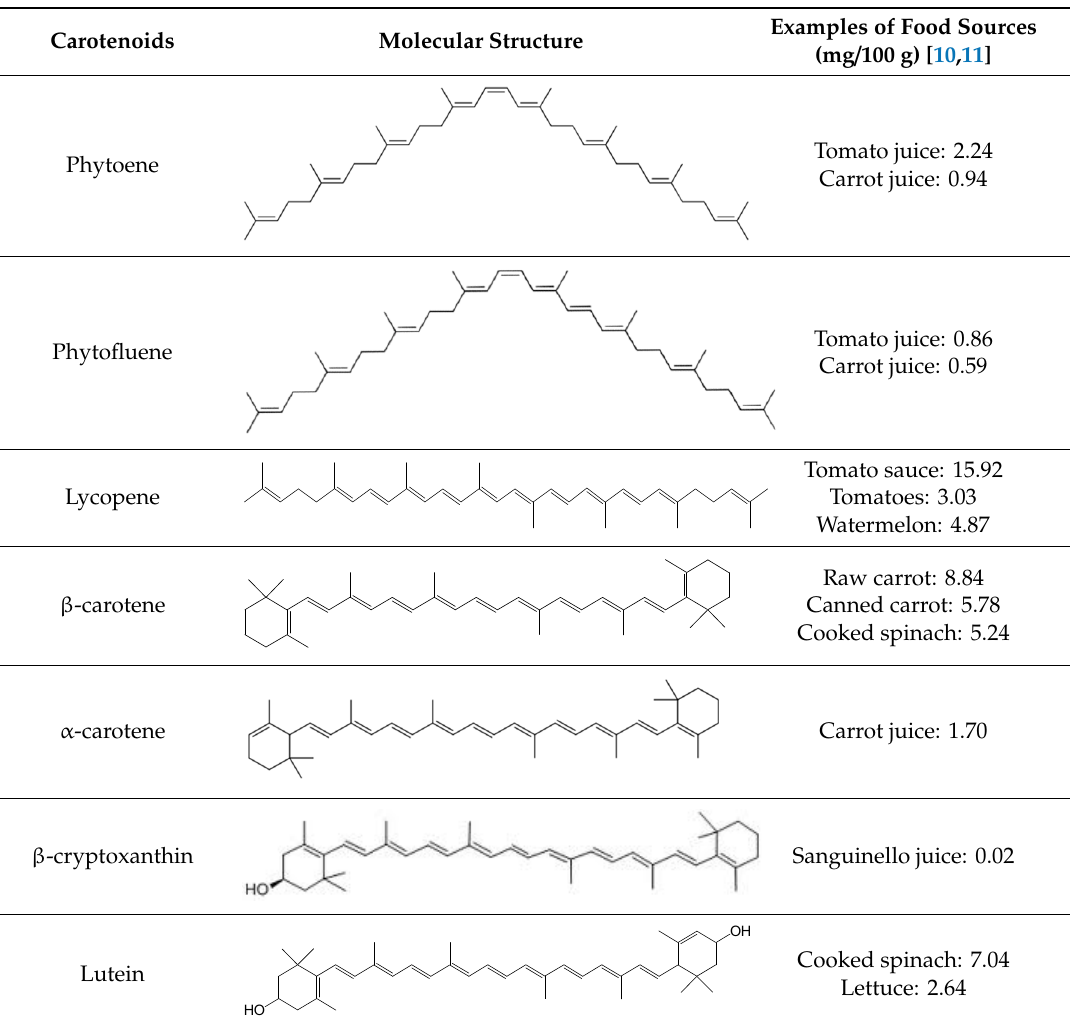
Table 1. Main dietary carotenoids.